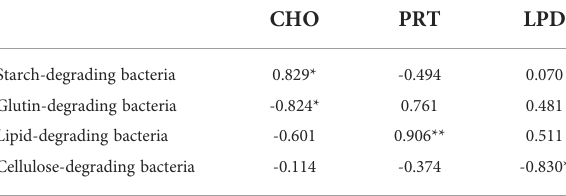
TABLE 1 Correlation between organic matter in sediment and the number of